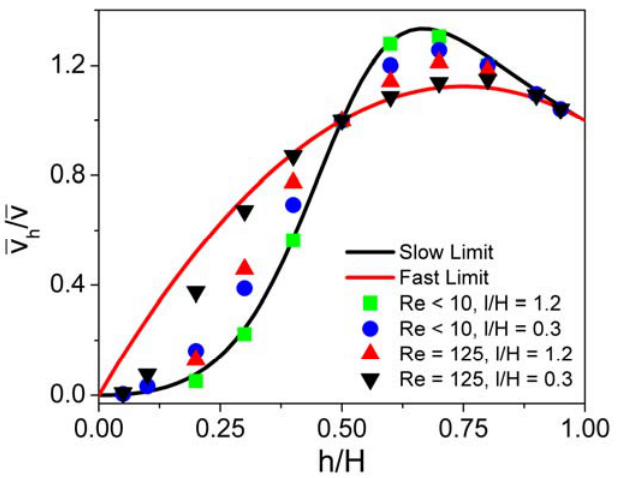
Figure 4. Average flow velocity in the region above or below the sensor as a function of the size of the gap on that side relative to the total channel height. The slow and fast limit expressions are compared with simulation data for a range of Reynolds numbers and geometry